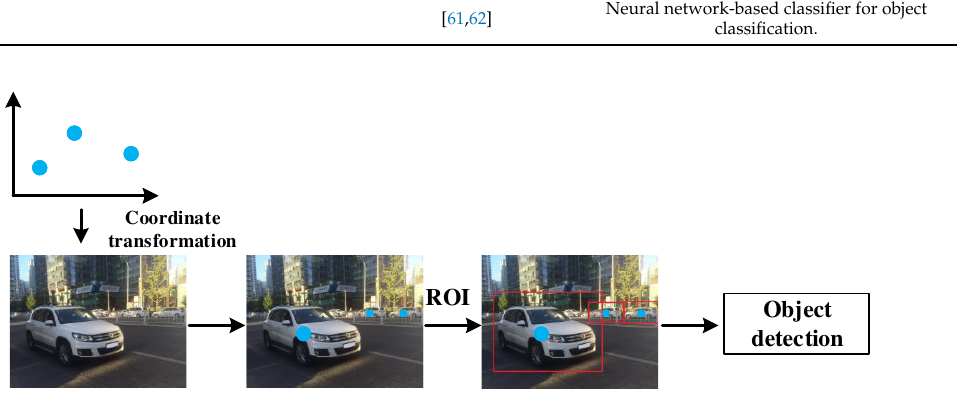
Figure 4. Data level